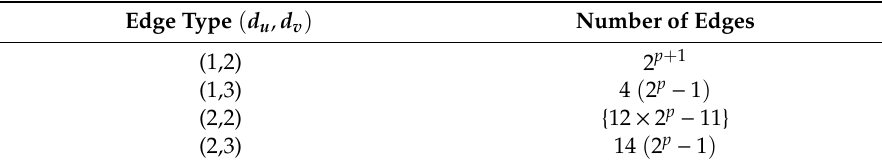
Table 1. Edge partition of NS 1 [ p ] polypropylenimine octaamin